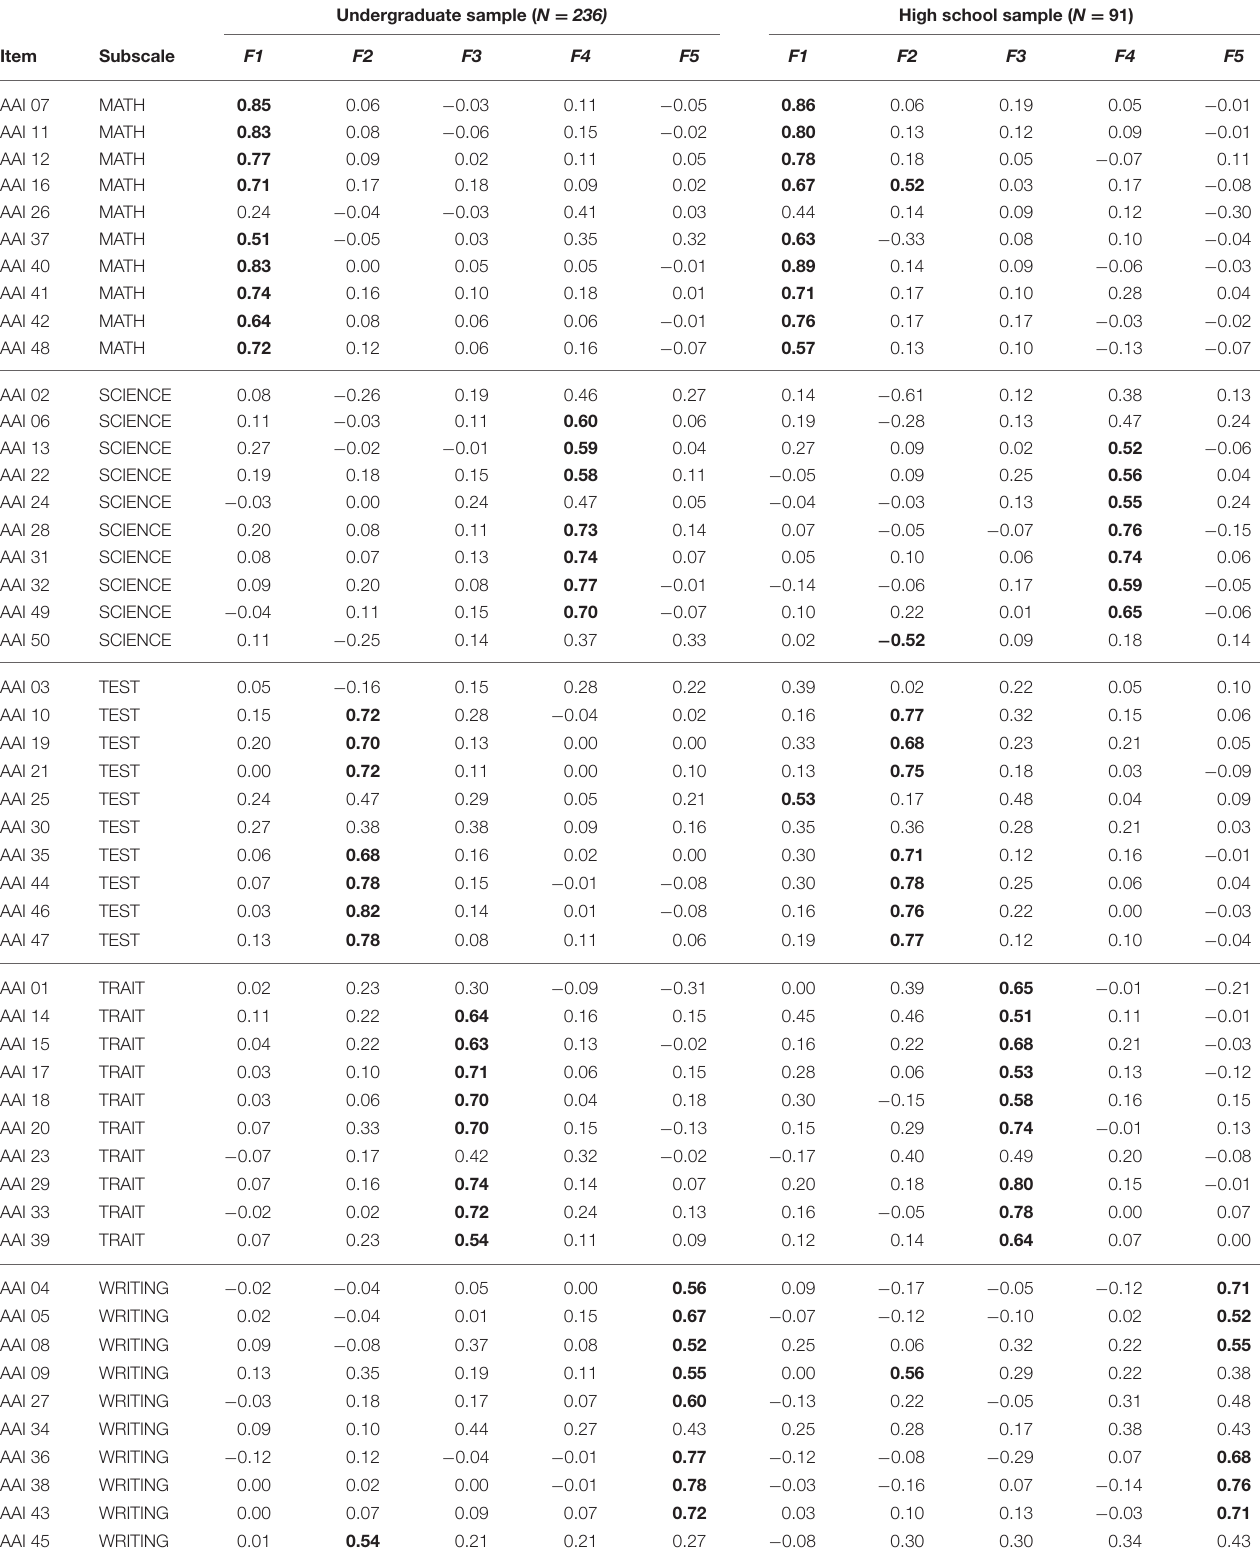
Factor loadings for Study 2 are presented in the columns on the left, Study 3 on the right. Factor loadings > 0.5 depicted in bold to illustrate items that have high loadings on a particular factor. Frontiers in Psychology |